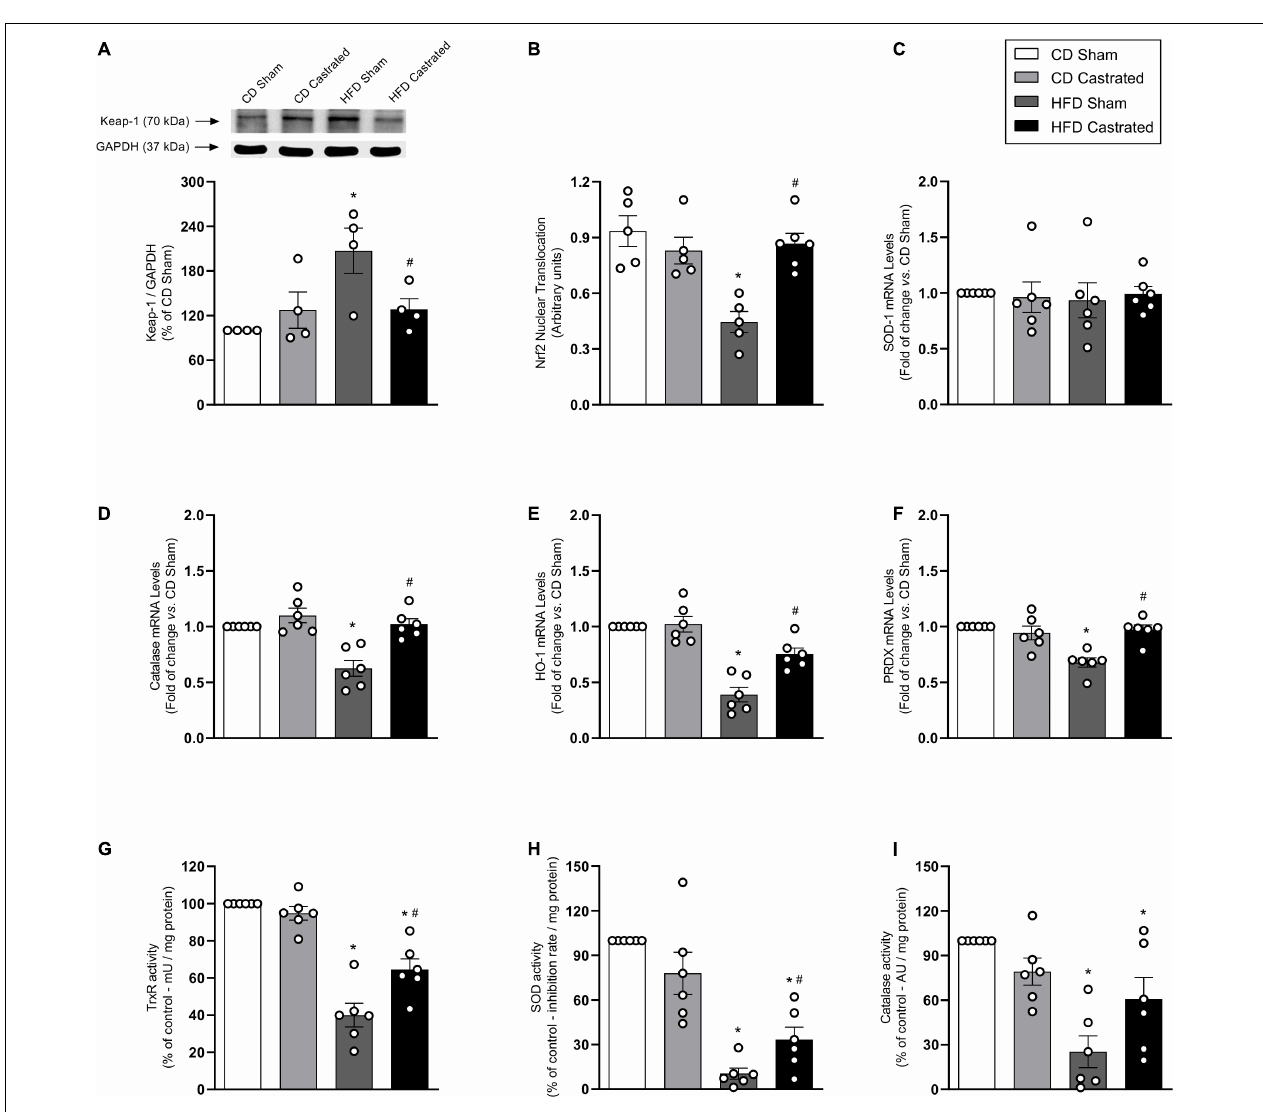
FIGURE 3 | Testosterone contributes to downregulation of the nuclear factor E2–related factor 2 (Nrf2) antioxidant system in high fat diet (HFD)-fed mice. The experiments were performed in aortas isolated from the various experimental groups. Total levels of Keap-1 [ (A) n = 4 for each experimental group]. Nuclear accumulation of Nrf2 [ (B) n = 5 or 6 for each experimental group]. mRNA expression of genes regulated by Nrf2: SOD-1 [ (C) n = 6 for each experimental group], catalase [ (D) n = 6 for each experimental group], heme oxygenase-1 [ (E) n = 6 for each experimental group] and peroxiredoxin-1 [ (F) n = 6 for each experimental group]. Activity of antioxidant enzymes thioredoxin reductase [ (G) n = 6 for each experimental group], SOD [ (H) n = 6 for each experimental group] and catalase [ (I) n = 6 for each experimental group]. Data are expressed as mean ± SEM. * p < 0.05 vs . CD Sham; # p < 0.05 vs . HFD Sham.